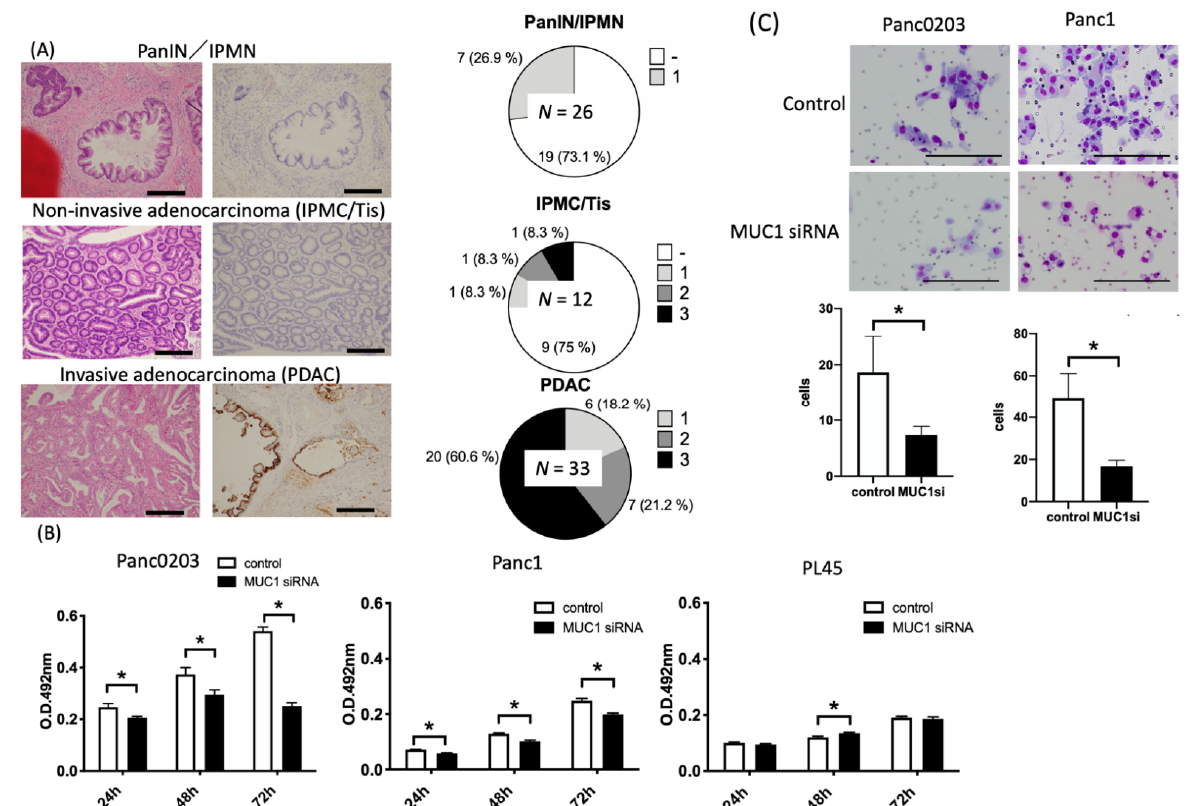
Figure 1. Expression of MUC1 in pancreatic ductal lesion tissues and its involvement in cell proliferation and invasion. ( A ) MUC1 expression in pancreatic intraepithelial neoplasia/intraductal papillary mucinous neoplasm (PanIN/IPMN); adenocarcinoma in situ; and PDAC samples are shown. The left panel is hematoxylin-eosin stained and the right panel anti-MUC1 immuno-stained. The degree of MUC1 expression at the cell membrane was assessed semi-quantitatively as 0 (negative), 1 (weak intensity), 2 (intermediate intensity), and 3 (strong intensity). (×100; scale bar; 250 µm) A one-way ANOVA comparison of the three groups showed no statistically significant differences ( p = 0.69). ( B ) The MTS assay under transfection with MUC1 siRNA at 24, 48, and 72 h in PDAC cell lines (* p < 0.05). ( C ) Matrigel invasion assay showing the promotion of invasive capability in Panc0203 and Panc1 cells transfected with MUC1 siRNA. (×100; scale bar; 100 µm).